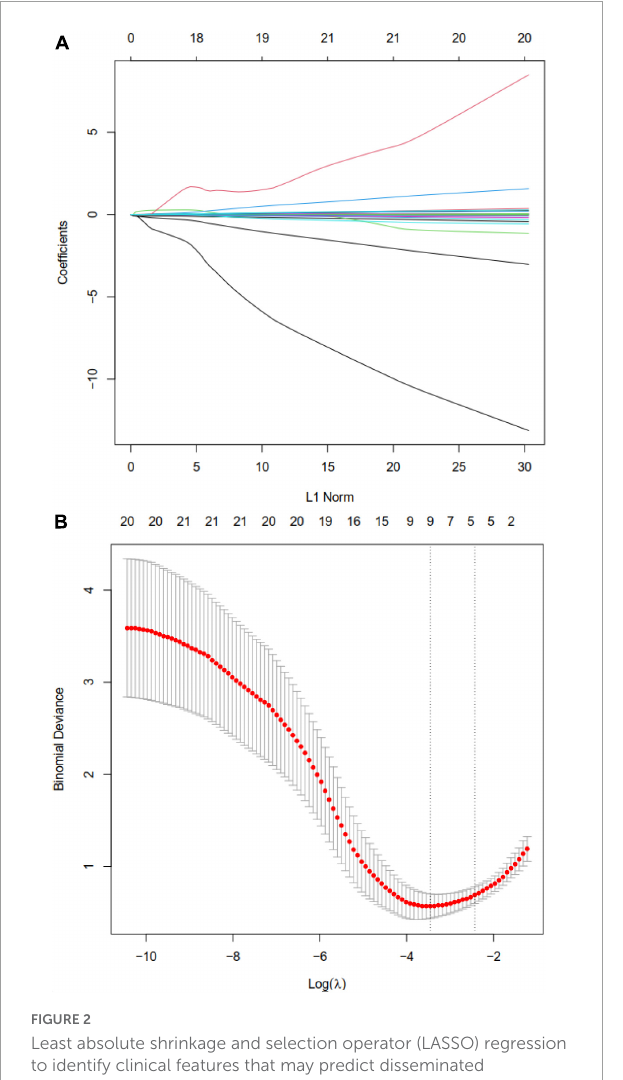
FIGURE2 Least absolute shrinkage and selection operator (LASSO) regression to identify clinical features that may predict disseminated intravascular coagulation (DIC) in heatstroke patients. (A) LASSO coefficient profiles. (B) LASSO regression using 10-fold cross-validation and the “minimum plus one standard error” criterion to identify the optimal penalization coefficient lambda ( λ ).